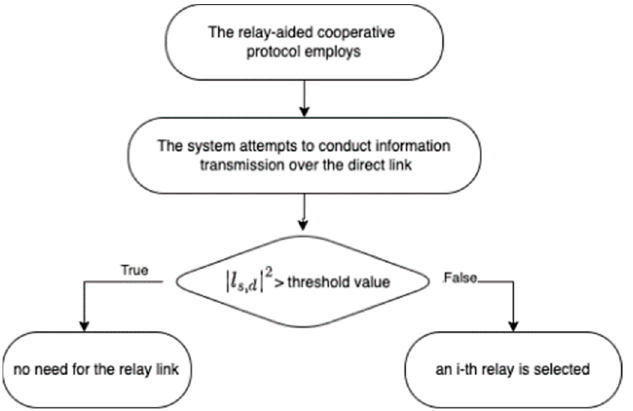
Figure 2. Criteria for relay selection.